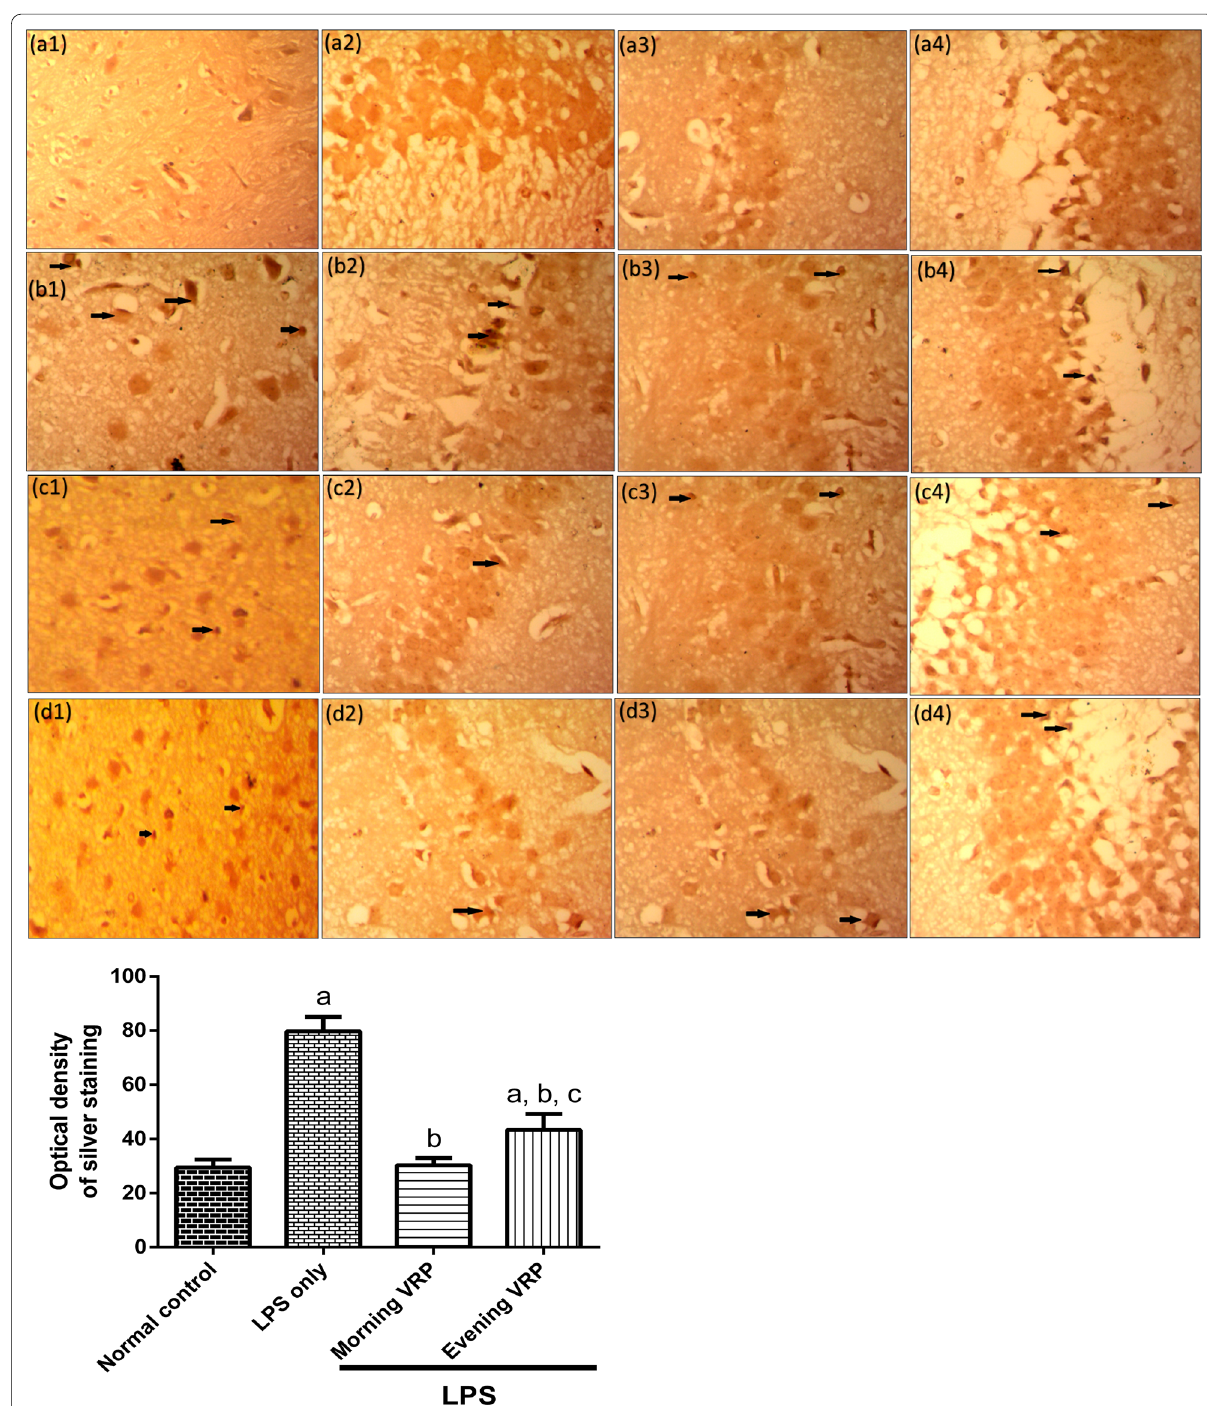
Fig. 3 Effect of VRP on histopathological examination by Bielschowsky silver staining and quantitative measurement of optical density of the silver staining. a Normal control, b LPS only, c Morning VRP, and d Evening VRP. Four different sectors were examined; 1 : whole brain tissue, 2 : CA1 area, 3 : CA3 area, and 4 : dentate gyrus area. Data are expressed as the mean SD and were analyzed using one-way ANOVA followed by Tukey post hoc ± test. Values were considered significantly different at P < 0.05. a: significant versus normal control, b: significant versus LPS only, and c: significant versus morning VRP. LPS: lipopolysaccharides, VRP: